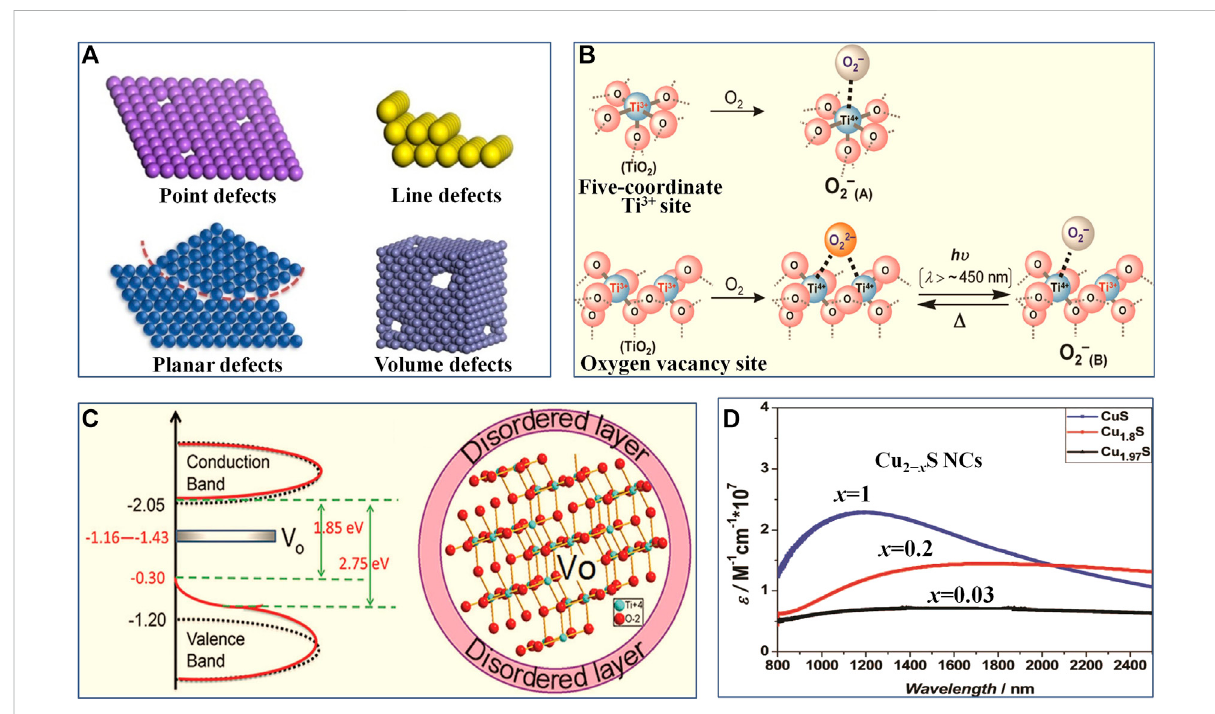
FIGURE 1 (A) Schematic of various defects in crystals. Reproduced with permission from Xie et al. (2020). Copyright © 2020 American Chemical Society. (cid:129) (B) Illustrations of O 2 adsorption on partially reduced TiO 2 surface to form O 2 − (adsorbed type A) and O 2 adsorption on oxygen vacancy defective (cid:129) O 2 − under light irradiation (adsorbed type B). Reproduced with permission from Komaguchi et al. (2010). Copyright © 2010 TiO 2 surface to form American Chemical Society. (C) Schematic density of states for TiO 2 P25 Degussa (black dotted line) and black TiO 2 nanoparticle with oxygen vacancies (red line), Vo represents the localized states created by oxygen vacancies in black TiO 2 nanoparticle; illustration of the microstructure of